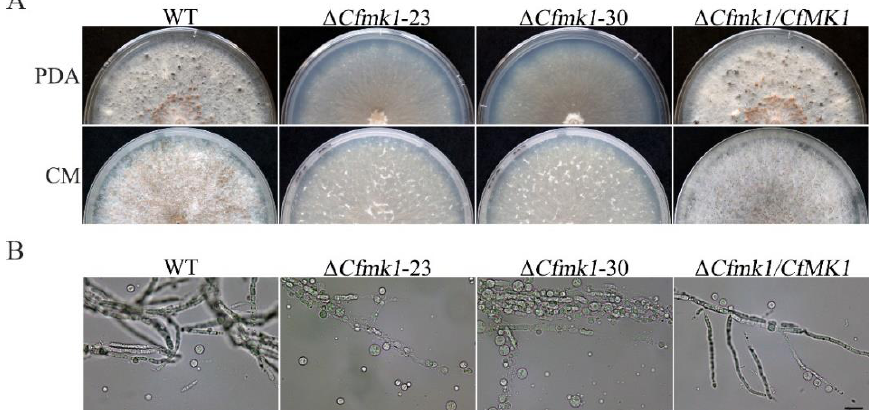
Figure 3. Defects in hyphal cell wall integrity of the Cfmk1 deletion mutant. ( A ) Hyphae of the WT, Δ Cfmk1-23 , Δ Cfmk1-30 , and Δ Cfmk1 / CfMK1 cultured on PDA and CM for four weeks. ( B ) Hyphae harvested from 24-h-old PDB cultures of the same set of strains were examined after digestion with a mixture of lytic enzymes for 40 min. Bar = 20 µ